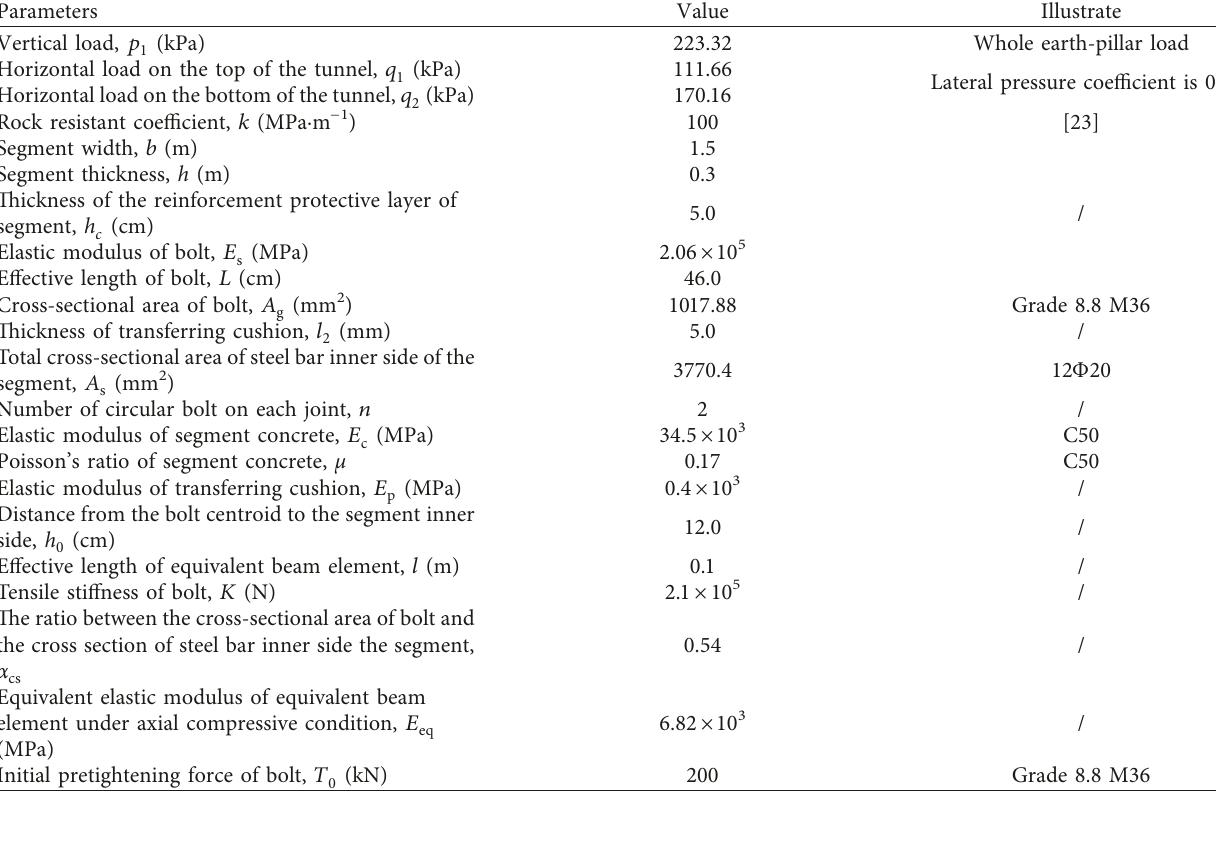
Table 5: Summary of calculation parameters.